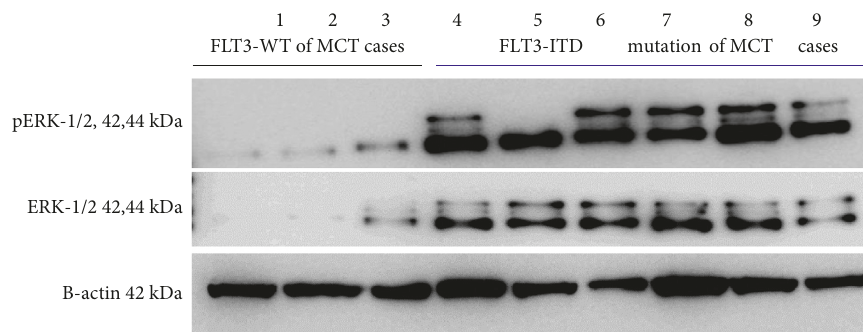
Figure 4: Canine MCT FLT3-ITD mutation activates ERK signaling. Total ERK1/2 and phosphorylated ERK1/2 expression in MCT was assessed by immunoblot analysis. Three cases of MCT-bearing dogs with FLT3-WT and six cases of MCT-bearing dogs with FLT3-ITD mutation was represented as indicated in the